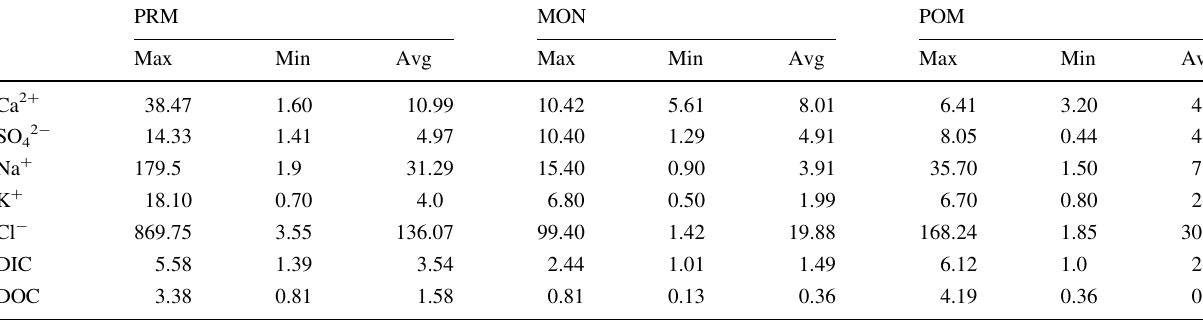
Table 2 Max, min and average values of ions for different